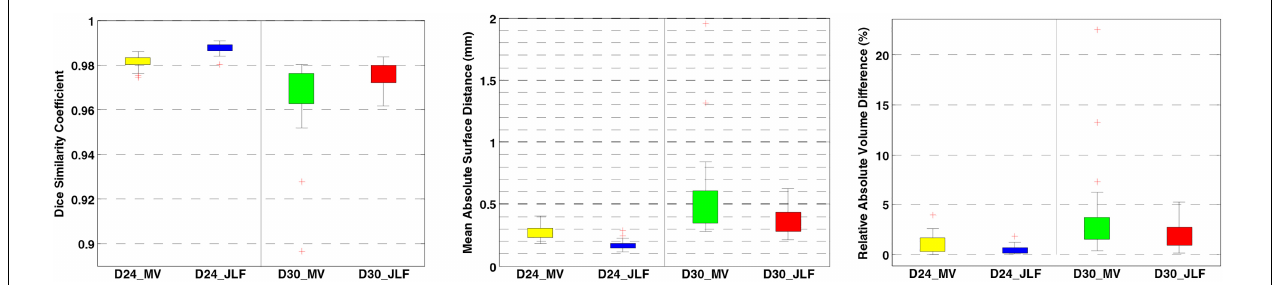
FIGURE 3 | Brain extraction evaluation results on D24 and D30. From left to right: DSC, MASD, and RVD. DSC, dice similarity coefficient; MASD, mean absolute surface distance; RVD, relative volume difference; MV, majority voting; JLF, joint label